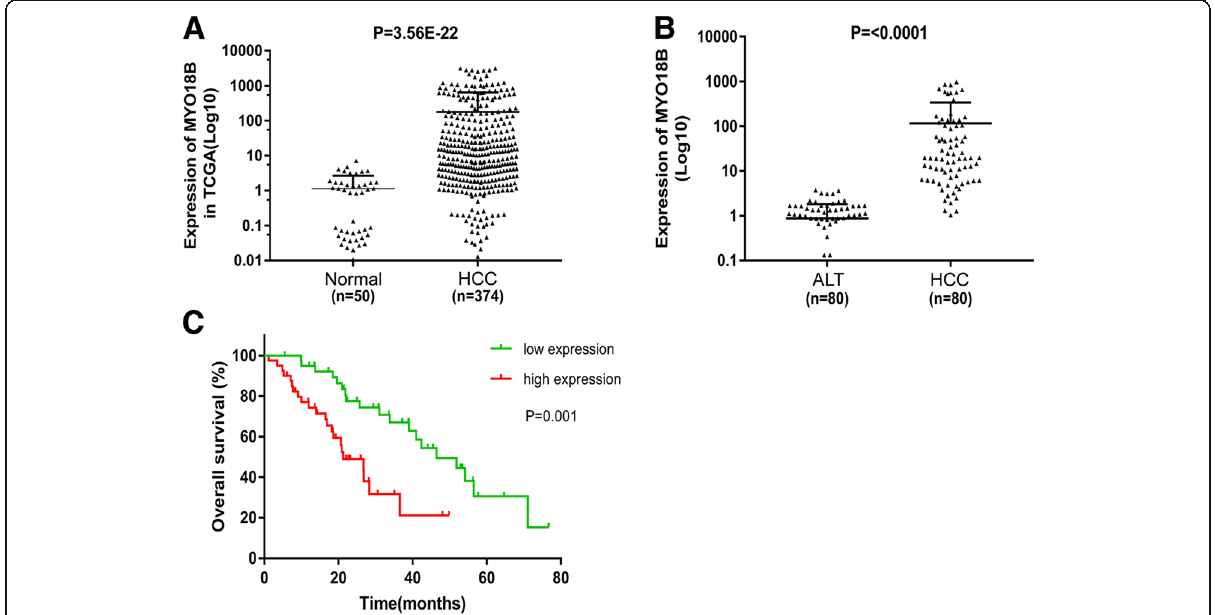
Fig. 1 Relative MYO18B expression in tumor tissues and its clinical significance. a MYO18B was over-expressed in tumor tissues ( n =374) compared with normal tissues ( n =50), which was analyzed using TCGA database. b MYO18B was up-regulated in tumor tissues ( n =80) compared with adjacent liver tissues (ALT), which was analyzed by qRT-PCR. c Kaplan-Meier survival analysis showed that MYO18B over-expression was correlated with worse overall survival in patients with hepatocellular carcinoma ( P